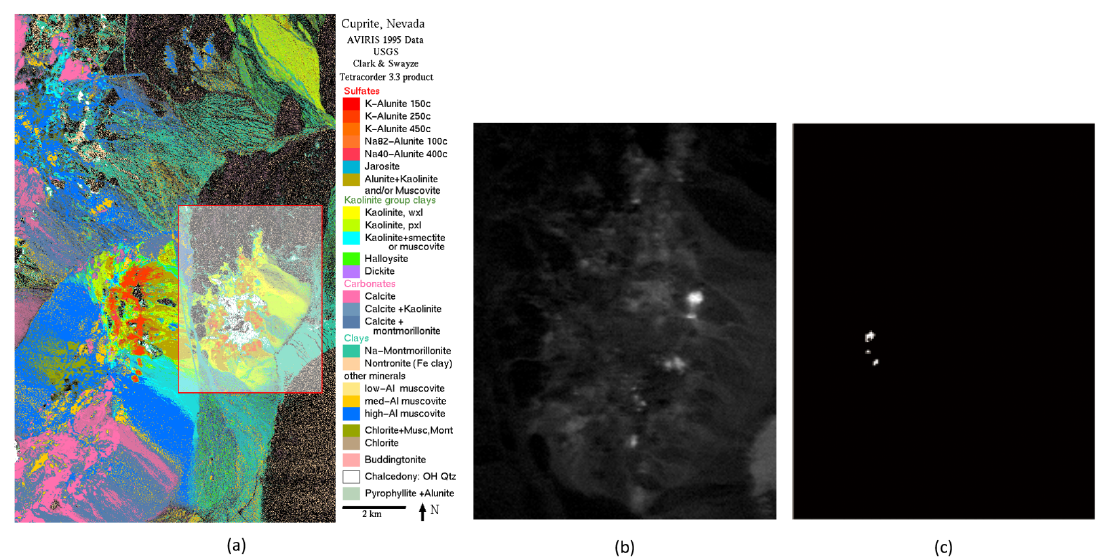
Figure 5. The Cuprite mining district of Nevada captured by AVIRIS in 1997. ( a ) The minerals map produced by the Tricorder 3.3 software [51]. We use a 250 × 191 pixel subimage of this data to conduct our experiment, which is marked by the red box. ( b ) The first band of our experimental data. ( c ) The distribution of the buddingtonite